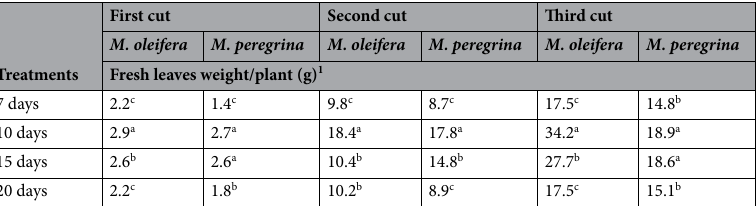
Table 2. The effect of irrigation frequency on fresh leaves weight of M. oleifera and M. peregrina at different cutting periods. 1 Means within each column with the same superscripts were not significantly different using Duncan Multiple Range Test at the 0.05 level of significance.